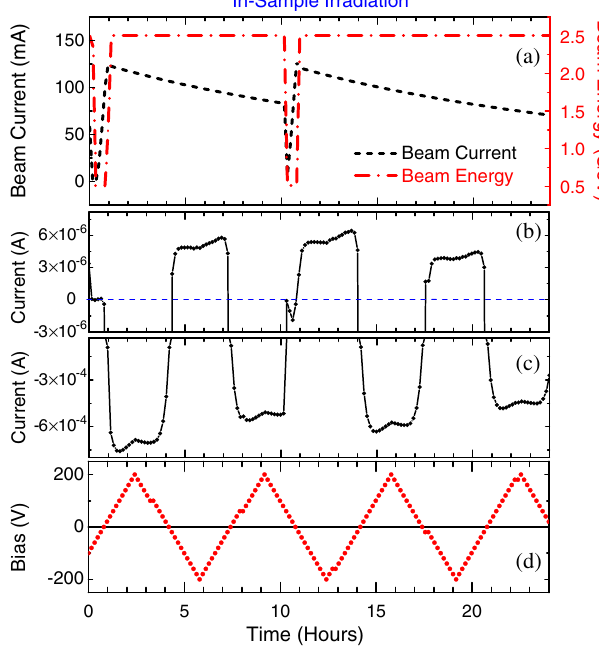
FIG. 11. Evolution as a function of time, during a 24 h KARA working cycle and irradiation in the in-sample configuration of (a) beam energy (red line) and beam current (black line), (b),(c) current measured at the clearing electrode, at different applied bias voltages (positive and negative, respectively), and (d) bias voltage applied to the clearing electrode.